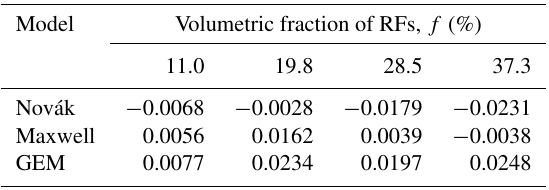
Table 3. Performance of the Novák, Maxwell, and GEM models quantified by the average deviation hydraulic conductivities ( d avg ) on a logarithmic scale for different values of f